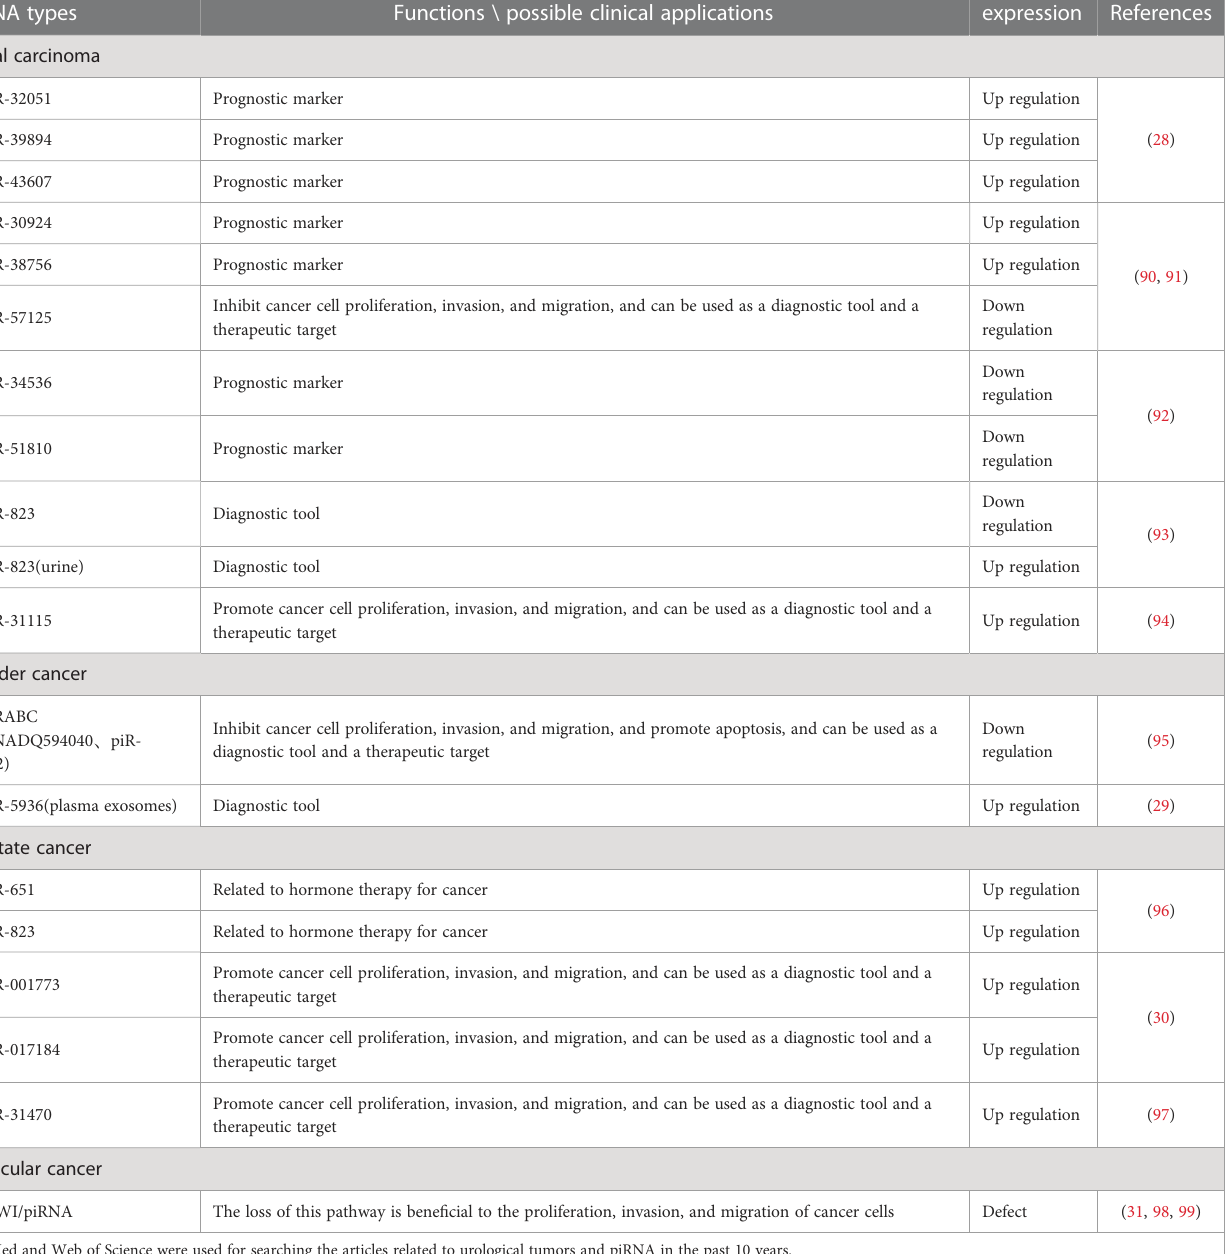
TABLE 2 Expression and application of piRNAs in urological